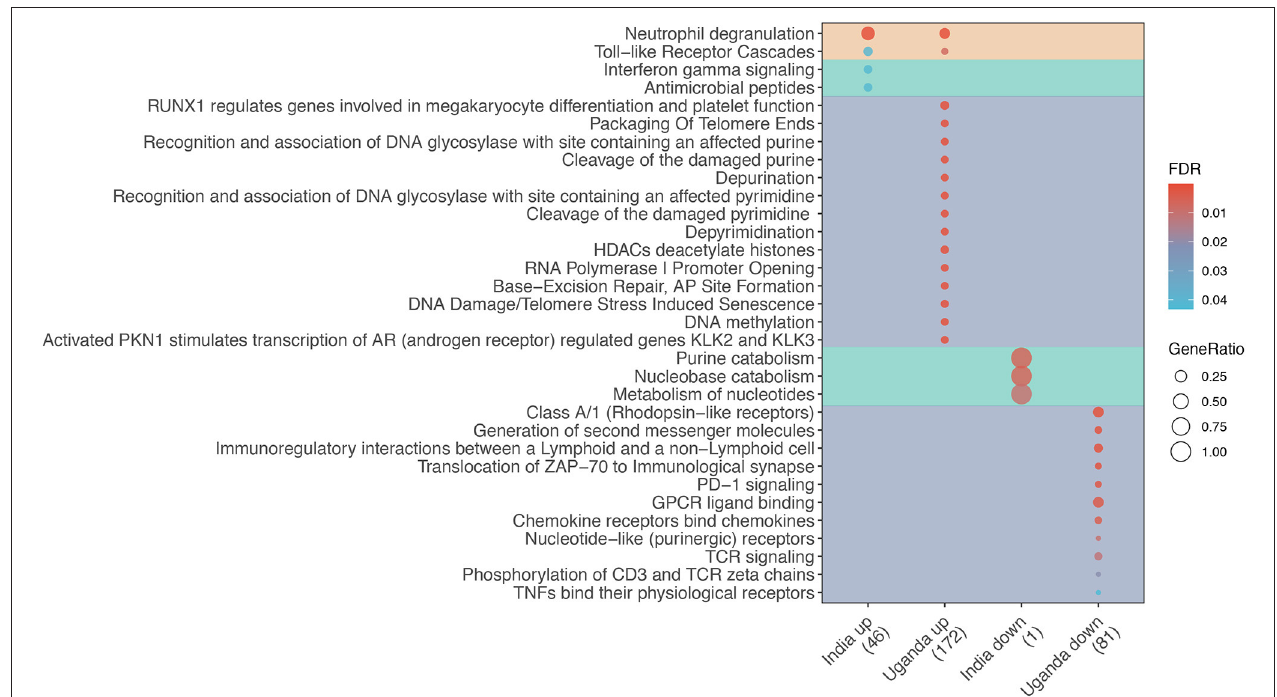
FIGURE 1 | Enrichment analysis of differentially expressed genes (DEG) for TB among adults living with advanced HIV by study site. Dot diameter represents the gene ratio for each pathway, and fill color represents the false discovery rate (FDR)-adjusted p -value for the change in gene expression. Shading identifies shared (orange), India-specific (green), and Uganda-specific (purple)